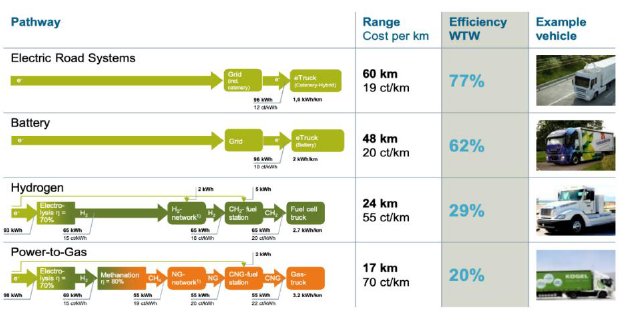
Fig. 10. Efficiency Of Vehicels